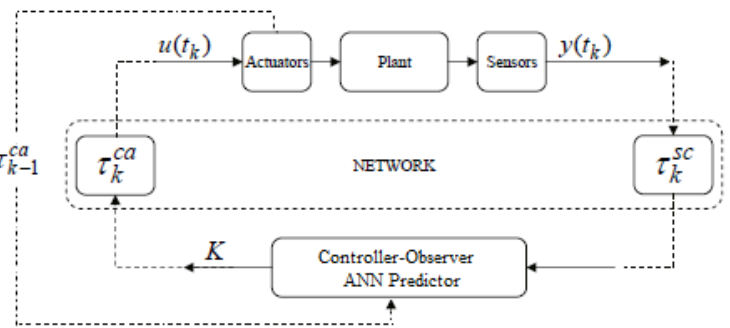
Figure 1. WSAN control system with induced